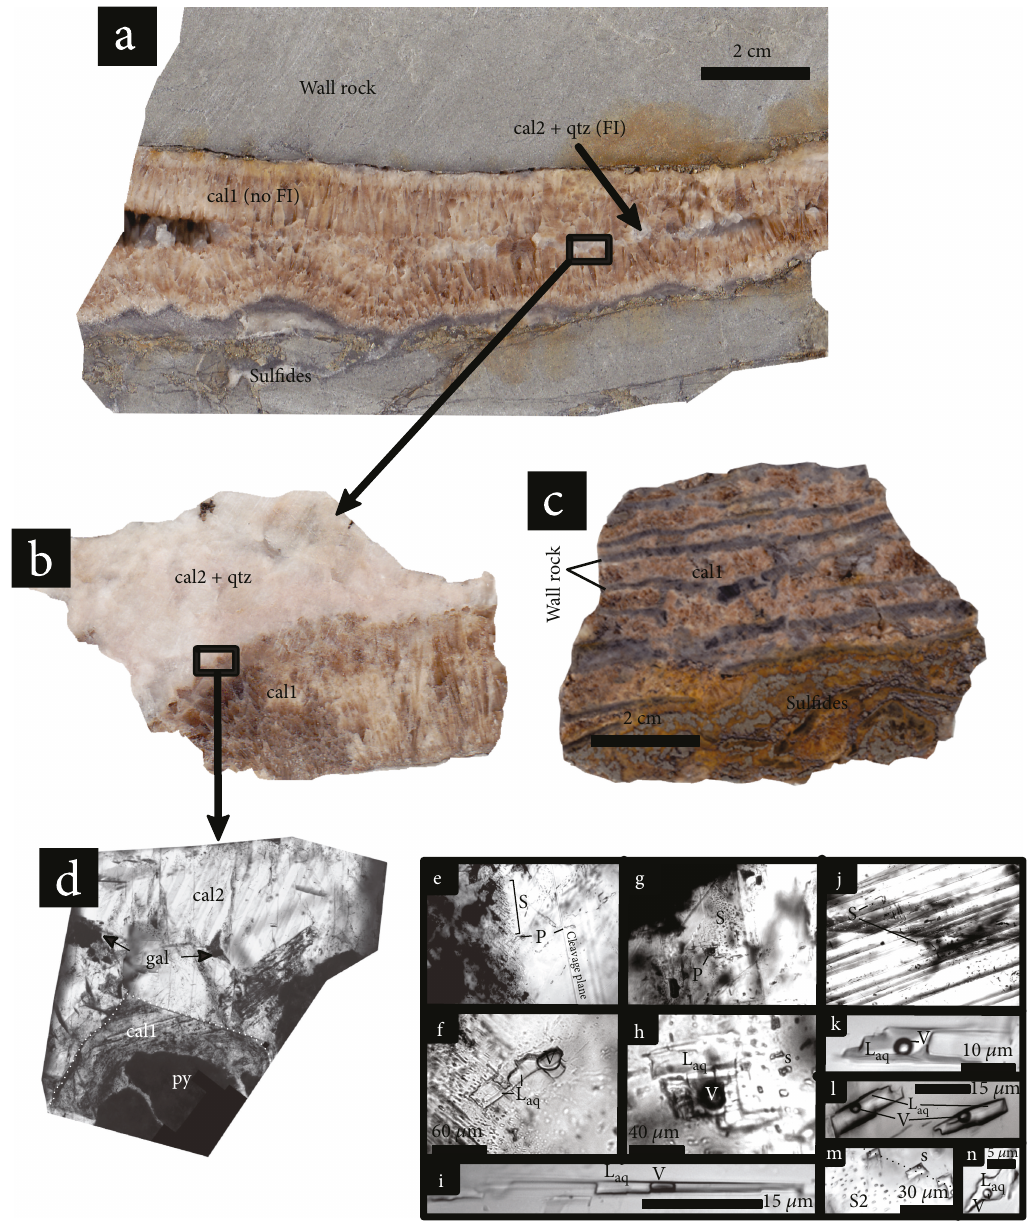
Figure 9: Petrographic characteristics of carbonate-quartz veins (WGVA). (a) Complete vein cross section (hand sample) showing early brown, comb-textured (acicular, hexagonal) carbonate lining vein wall (cal1), later white, massive, sparry carbonate and quartz (cal2 +qtz), and sul fi de-mineralized wallrock. (b) Enlarged view of the contact between cal1 and cal2 generations where euhedral crystals of cal1 contact cal2. (c) Banded ( “ zebra ” ) texture showing alternating layers consisting of sul fi de-mineralized wall rock laminae and cal2. (d) Thin-section photomicrograph (transmitted light) showing the paragenetic sequence of early pyrite (py) surrounded in zoned, euhedral brown carbonate (cal1), followed by massive white-orange carbonate (cal2) in fi lling and late galena in fi lling fractures and pits in cal2. (e-h) Transmitted light (ppl) photomicrographs (at 20 ° C) showing large primary ( “ P ” ) two-phase ( L + V ) inclusions and aq planes of much smaller secondary ( “ S ” ) two-phase ( L + V ) inclusions in cal2. Images (f) and (h) show more highly magni fi ed areas of aq the central parts of images (e) and (g), respectively. (i) Transmitted light (ppl) photomicrograph (at 20 ° C) of a long, rectangular primary two-phase ( L + V ) inclusion in cal2. (j) Transmitted light (ppl) photomicrograph (at 20 ° C) of a planar trail of secondary inclusions aq cross-cutting cal2 cleavage planes. (k-l) Secondary fl uid inclusions in cal2 containing two phases ( L + V ) at 20 ° C. (m) Transmitted light aq (ppl) photomicrograph (at 20 ° C) of an irregularly shaped secondary two-phase inclusion ( L + V ) in cal1. (n) Transmitted light (ppl) aq photomicrograph (at 20 ° C) shows two types of secondary inclusion morphologies in cal2: rectangular to irregular two-phase inclusions values (see text ( “ S ” ) and later ( “ S2 ” ) rectangular two-phase inclusions with rounded edges. The latter inclusions tend to show lower T h for